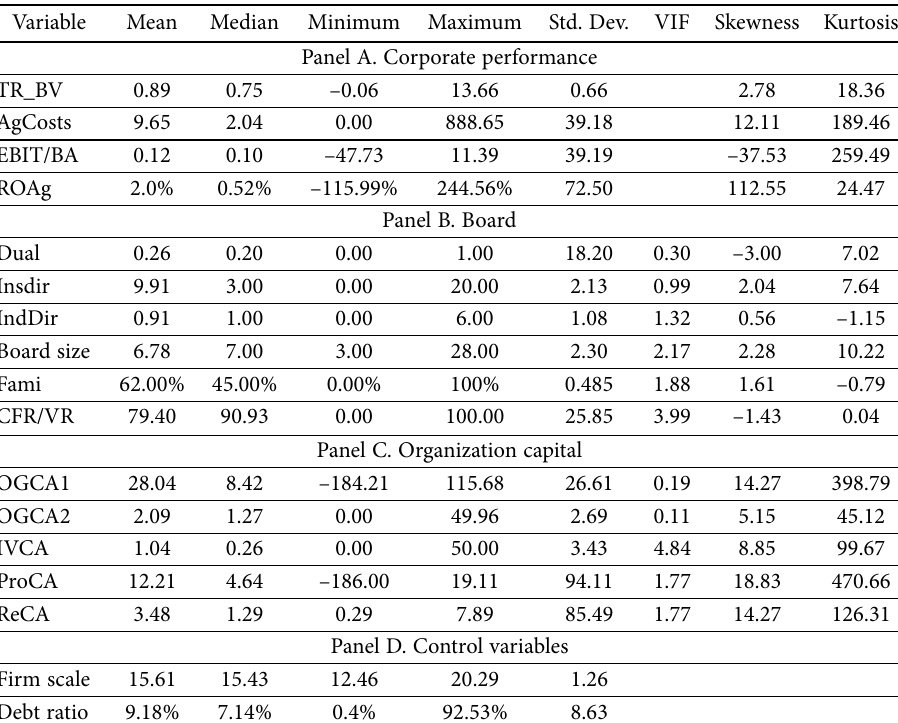
Table 1. The estimation results show a non-normal distributionl therefore, the RE TSLS models are used with the panel data. To further examine the results of no multi-colinearity in measurement of the Variance Inflation Factor (VIF) for each independent variable estimated in this study. We find that the average VIF is below 5 which is the threshold value, indicating whether a multi-colinearity problem is inclined to occur. Therefore, the multi-colinearity is not a problem in our